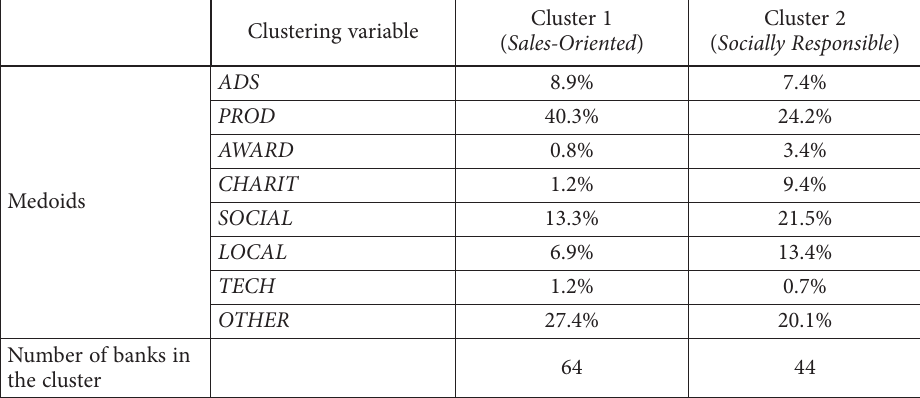
Table 3. SLBs’ Facebook activity models (k-medoid